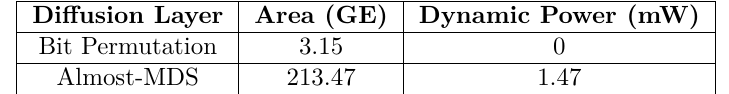
Table 5: TI circuits for diffusion layer choices (ASIC Technology: